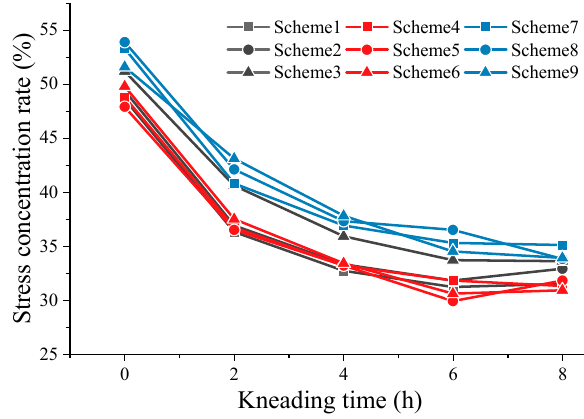
Figure 12. Results for contact stress concentration rate.